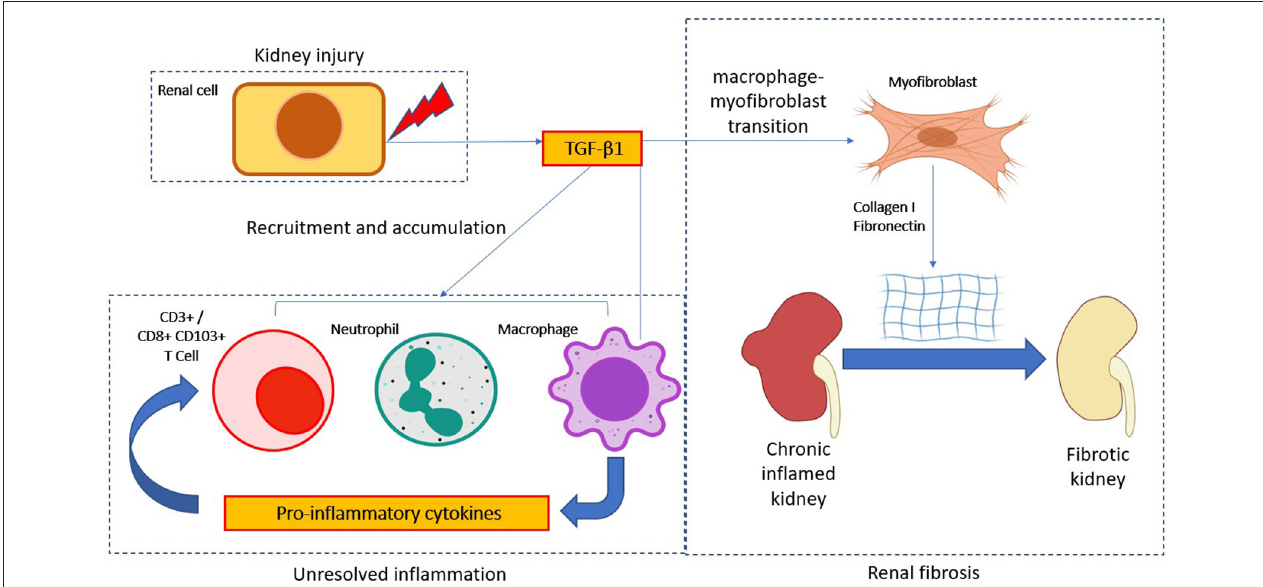
FIGURE 1 | TGF- β 1 in immune cell mediate CKD progression. TGF- β 1 modulates immune cell activity in the progression of chronic kidney disease (CKD). After kidney injury, TGF- β 1 is released by kidney cells to aid the resolution of inflammation. However, persistent TGF- β 1 signaling activation would promote a chronic